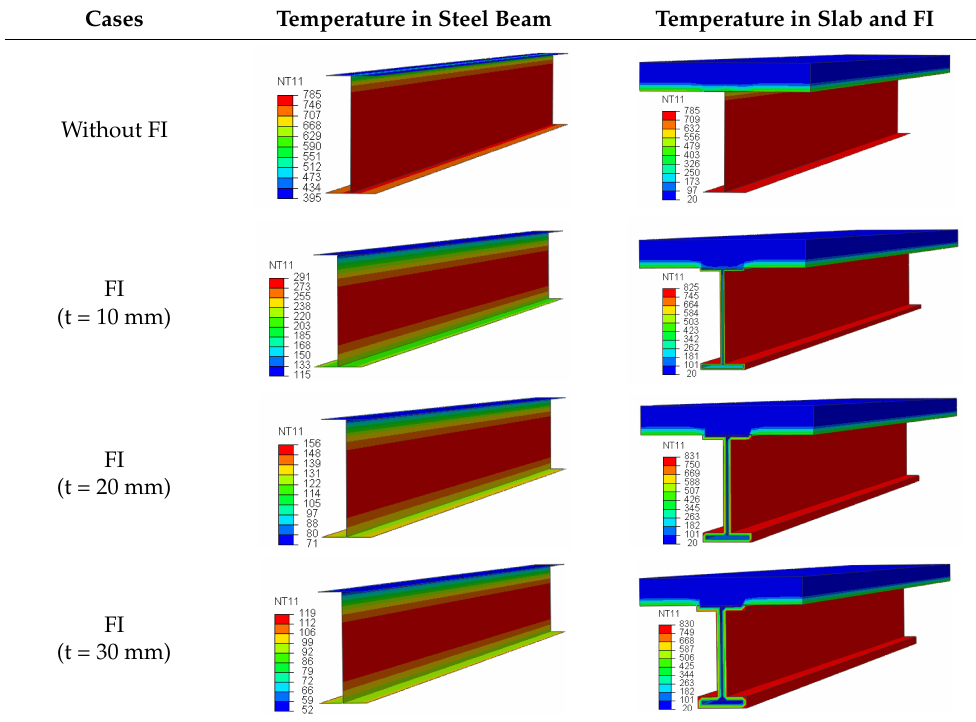
Table 4. Temperature distribution in ISO-834 fire at 30